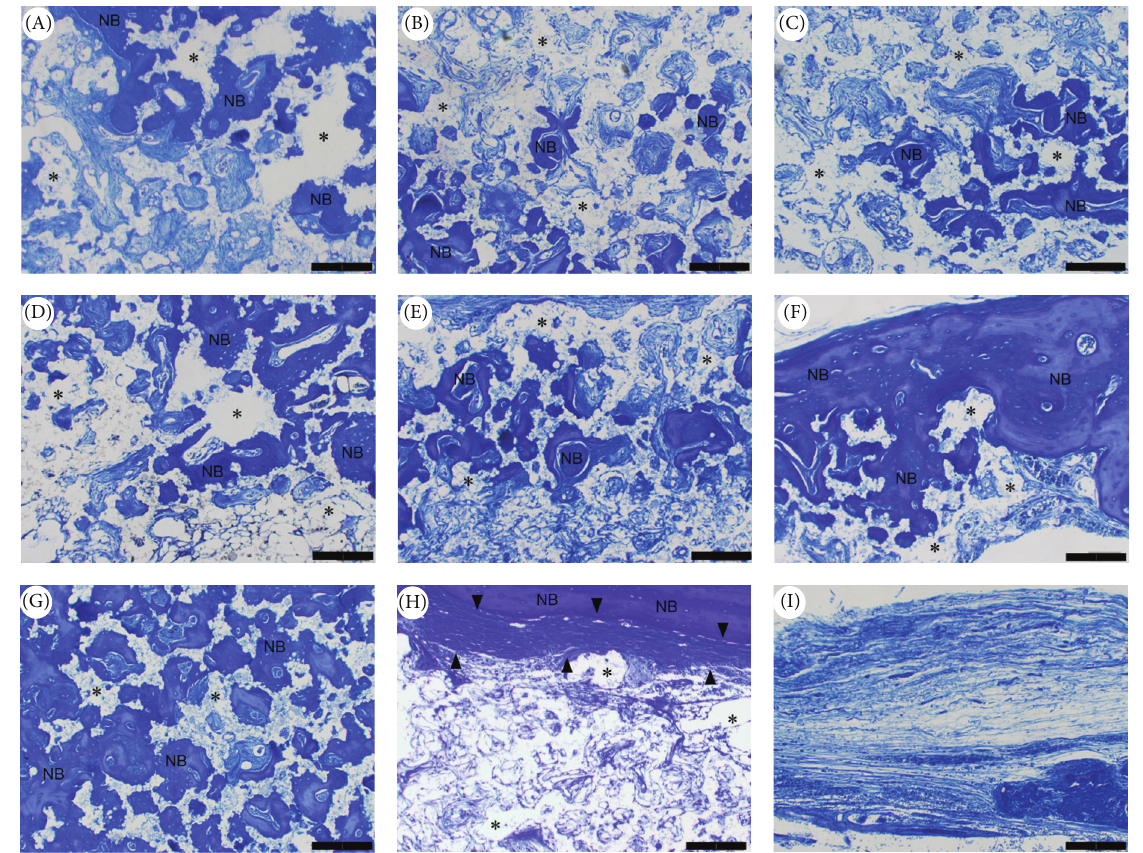
Figure 4: High magnification images of aniline blue staining. Capital letters A–I correspond to the treatment groups. Newly formed bone (NB) appears as a homogenous dark blue area, which includes osteocytes. The remaining 𝛽 -TCP shows a homogenous white area (asterisk). Bony bridging was nearly complete in groups F and G. Less residual 𝛽 -TCP was seen in group G. Original magnification 100x; scale bar = 200 𝜇